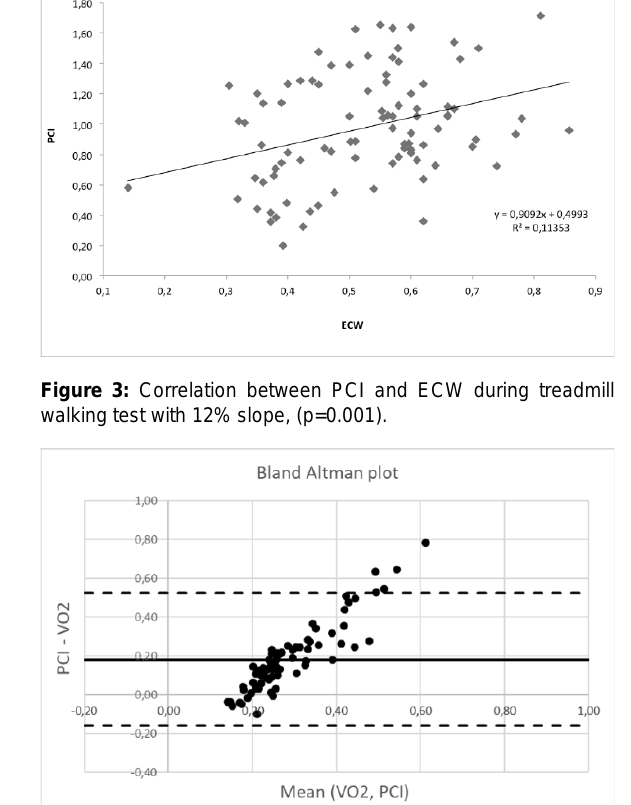
Table 1: Demographic characteristics of the sample.